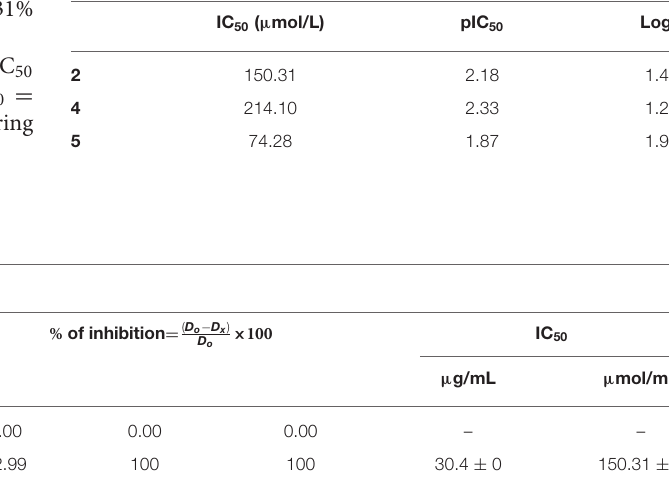
TABLE 6 | The MIC, pIC 50 , and LogP values of the studied ligands 2 , 4 , and 5 .